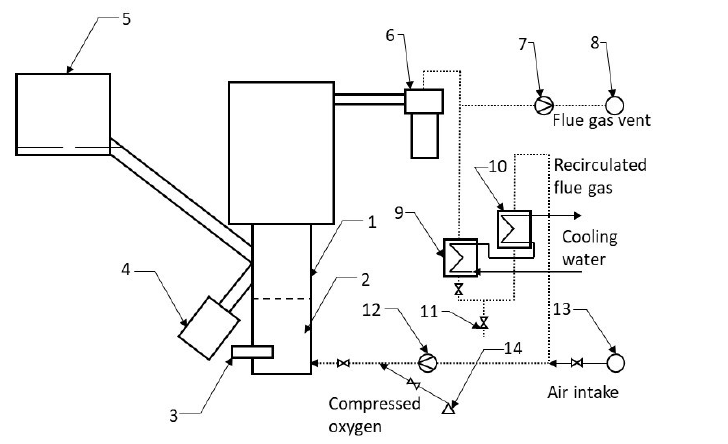
Figure 2. Scheme of the 30 kWth BFB experimental, (1) fluidized bed region, (2) distributor of the fluidizing gas, (3) gas burner mount, (4) fluidized bed spillway, (5) fuel feeder, (6) cyclone separator, (7) flue gas fan, (8) flue gas vent, (9) and (10) water coolers, (11) condensate drain, (12) primary fan, (13) air-suck pipe, (14) vessels with oxygen, (sketch based on [3]). Table 2. Oxy-fuel modes measured during the experiment are defined by secondary and primary oxygen flow ratios. mode 1 mode 2 mode 3 mode 4